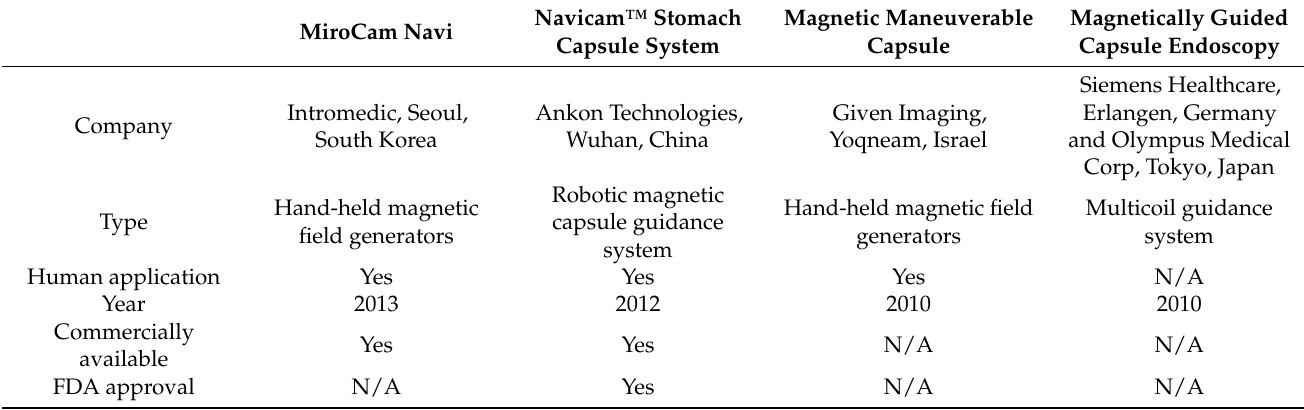
Table 1. Comparison of magnetically guided capsule